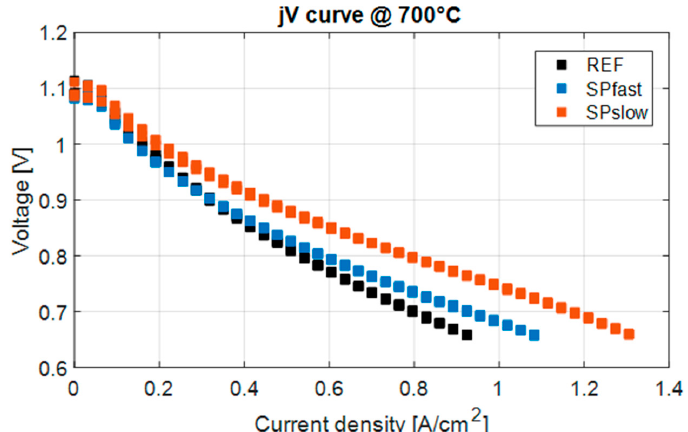
Figure 5. jV curves of samples REF (black markers), SPfast (blue markers), and SPslow (red markers) measured at 700 °C.